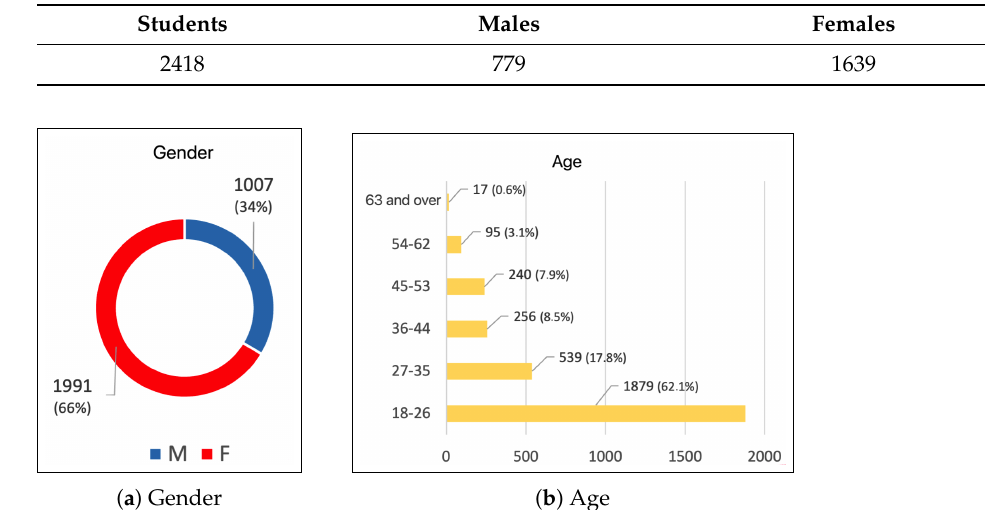
Table 2. Distribution by gender of students.